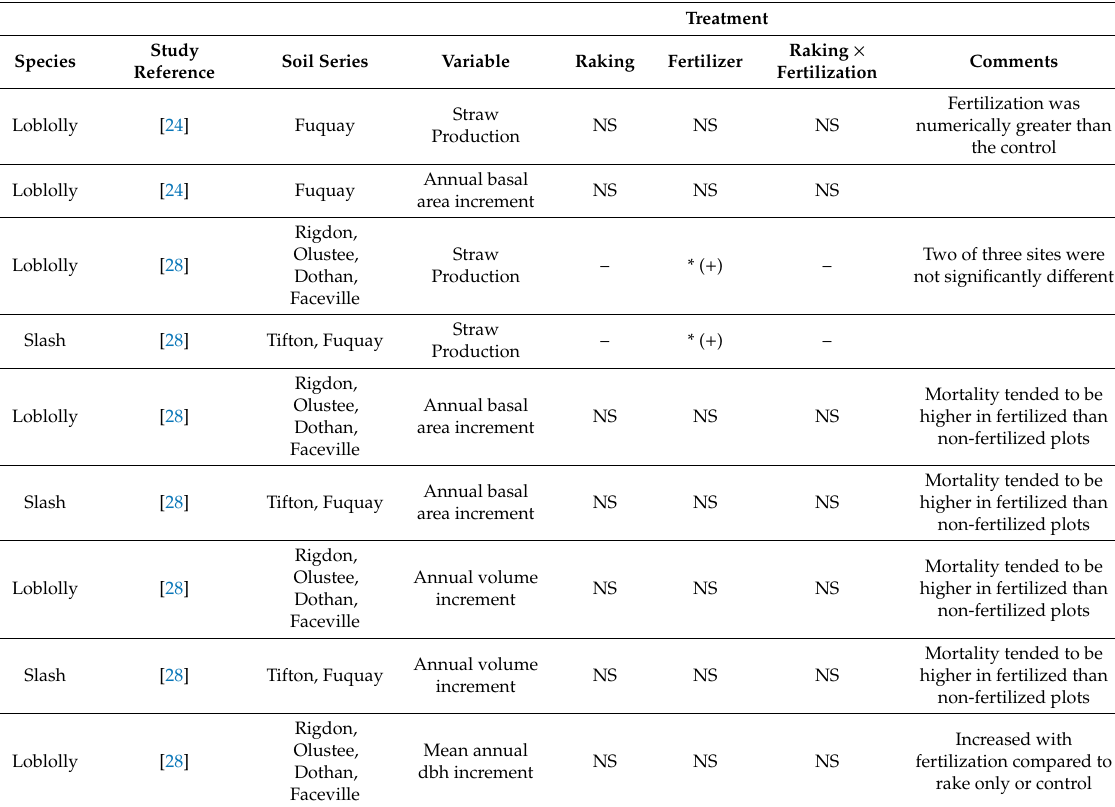
Table 7. Summarization of statistical test results for loblolly and slash pine straw production and growth and yield variables by treatment, soil series, and study. Non-significant (NS), ‘*(-)’ and ‘*( + )’ indicates either a negative or positive response associated with significant variables (*), and ‘—‘ indicates that a statistical test was not reported for that variable and treatment